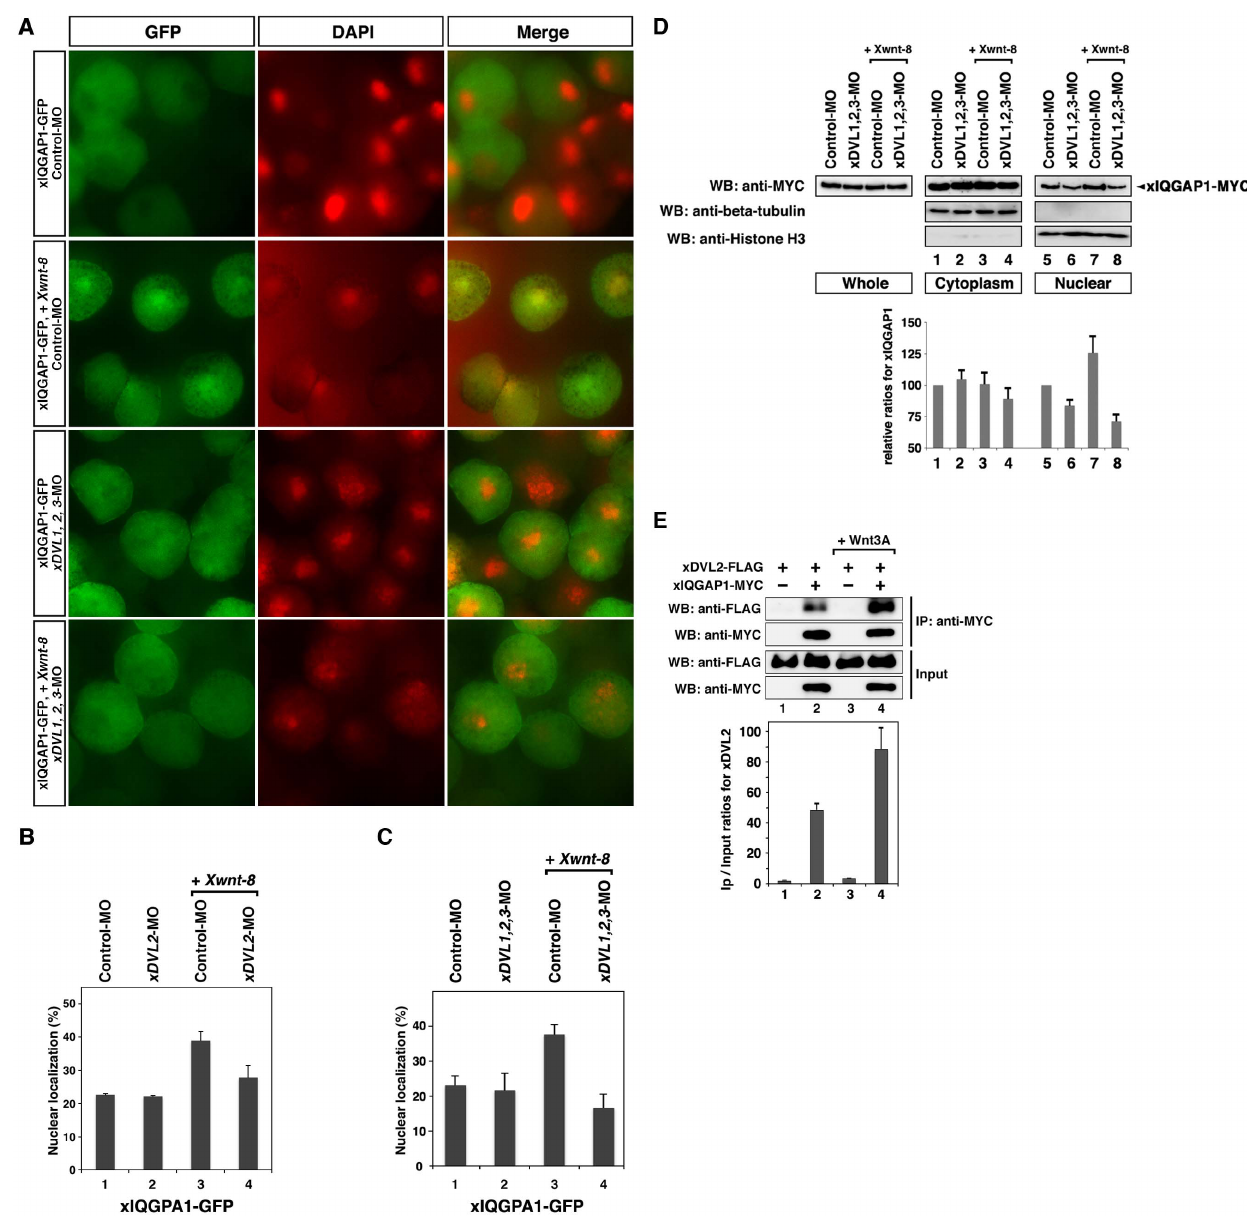
Figure 3. Localization of xIQGAP1-GFP. ( A ) Nuclear localization of xIQGAP1-GFP in stage 10 Xenopus animal cap cells over-expressing Xwnt-8 and xDVL1, 2, 3 -MO. GFP signals (left). DAPI staining of animal cap cells (center). Merge (right). ( B, C )The ratio of cells that had nuclear fluorescence signals. The following procedure is indicated in Figure 2C. ( B ) The ratio of nuclear localized xIQGAP1-GFP in cells injected with xDVL2 -MO. Lane 1: n=388, 22.7%, lane 2: n=361, 22.2%, lane 3: n=616, 20.9%, lane 4: n=534, 39.7%. P . 0.1 [between lane 1 and lane 2], P , 0.05 [between lane 3 and lane 4]. ( C ) The ratio of nuclear-localized xIQGAP1-GFP in cells injected with xDVL1 -MO, xDVL2 -MO and xDVL3 -MO in Xenopus animal cap cells at stage 10. Lane 1: n=1424, 23.0%, lane 2: n=1306, 21.6%, lane 3: n=1702, 37.6%, lane 4: n=1409, 16.6%. P . 0.1 [between lane 1 and lane 2], P , 0.01 [between lane 3 and lane 4]. ( D ) Cytoplasmic and nuclear distribution of xIQGAP1 in animal cap cells. MYC-tagged xIQGAP1 mRNA (100 pg) was injected into the animal poles of 4-cell stage embryos. The following procedure is indicated in Figure 2C. P , 0.1 [between lane 5 and lane 6], P , 0.1 [between lane 7 and lane 8]. ( E ) Interaction between ectopically-expressed xDVL2 and xIQGAP1 in HEK 293T cells. The transfected cultured cells were stimulated with recombinant human Wnt3A for 6 hours in lanes 3 and 4. The bars represent the IP/Input ratios of xDVL2-FLAG for each transfection. Error bars represent standard deviation of the mean in three experiments. Statistical significance was determined by Student’s t -test. P , 0.1 [between lane 2 and lane 4]. doi:10.1371/journal.pone.0060865.g003 GFP were mainly localized in the nuclei regardless of Wnt between xIQGAP1 and xDVL2 play important roles in both their stimulation. Moreover, xIQGAP1-DBR reduced expression of the nuclear localization and their Wnt-stimulated activities. Wnt target genes induced by xDVL2 , Xwnt-8 and ß-catenin . Taken In vertebrates, DVL1, DVL2 and DVL3 have redundant together, these results suggest that the domains mediating binding function in part [51], [52]. Depletion of all three xDVLs; xDVL1,